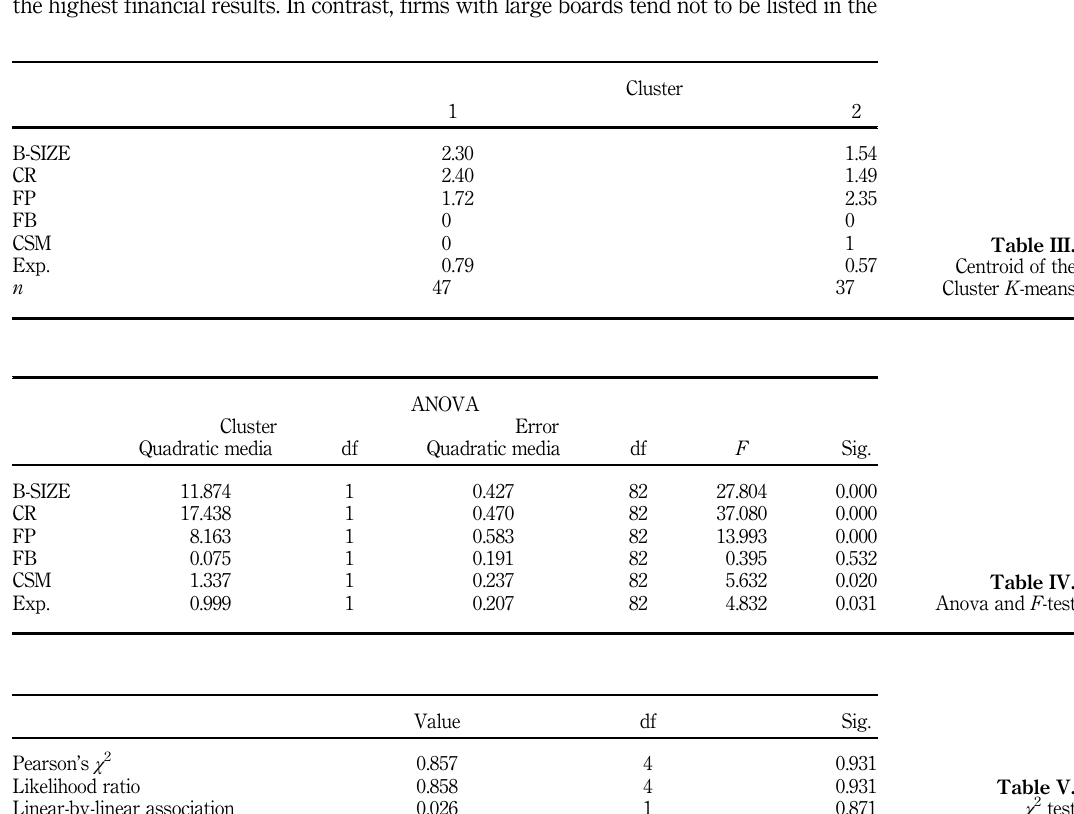
Table V. χ 2 test